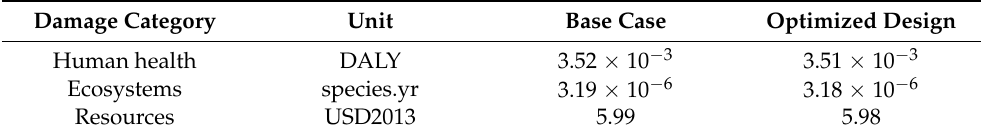
Table 5. Environmental impacts of damage categories for chitosan process alternatives.